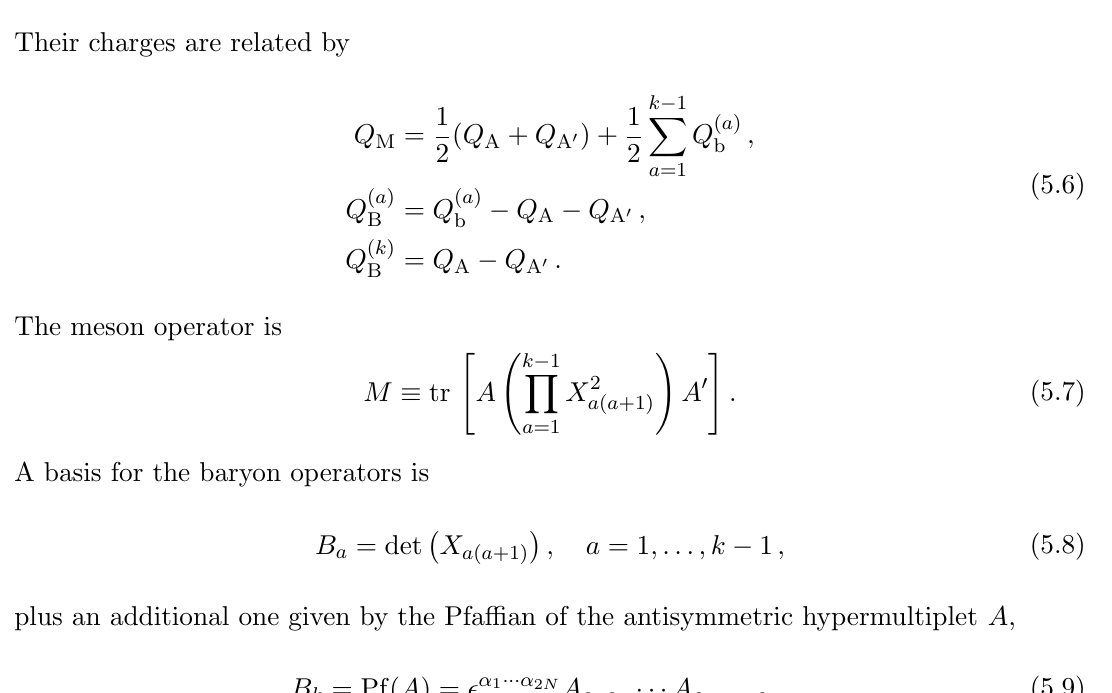
Figure 4 . Five-dimensional infrared quiver gauge theories giving rise to orbifold superconformal (cid:12)eld theories with odd n = 2 k +